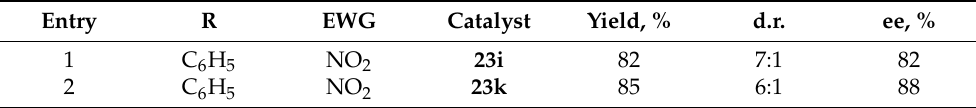
Table 3. Effect of crown ethers in the Michael addition of diethyl cyanofluoromethyl phosphonate ( 55 ) to electron deficient olefins 56 .